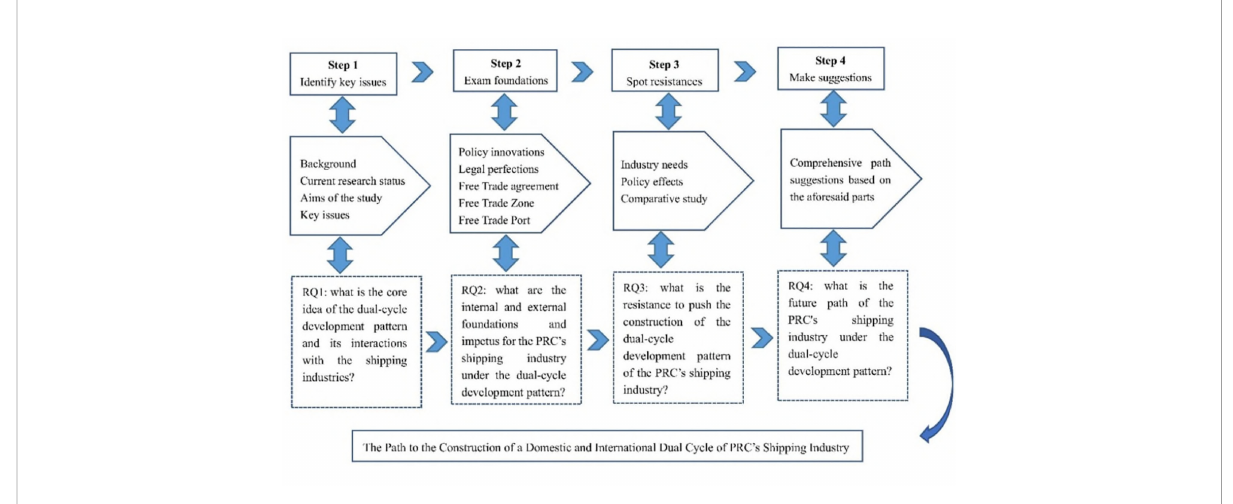
FIGURE 1 the conceptual framework of the